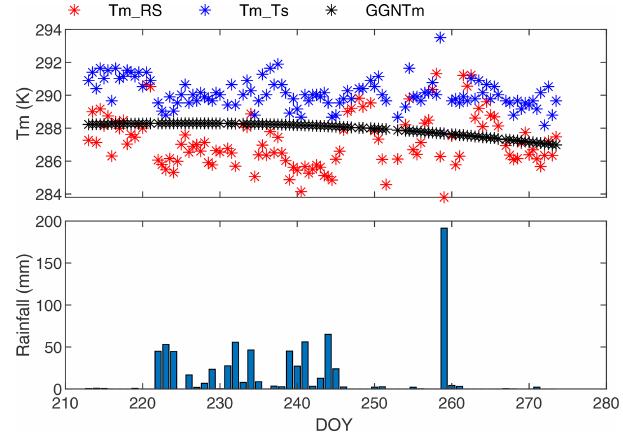
Figure 9. T m derived from radiosonde profiles, the T m − T s model, GGNTm from August to September in 2018 at KingsPark station, and the daily total rainfall at Hong Kong International Airport.